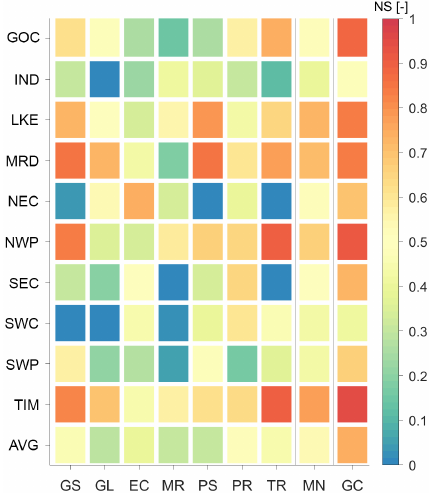
Figure 3. NS coefficients between the model and GRACE mas- con (cid:49) TWS over 10 Australian basins (in ordinate). The NS val- ues were computed based on CABLE (cid:49) TWS computed with seven different precipitation data (in abscissa), including GSWP3 (GS), GLDAS (GL), ECMWF (EC), MERRA (MR), PERSIANN (PR), TRMM (TR). The NS value of the mean (cid:49) TWS estimates (the av- erage of seven variants) is also shown (MN). The area-weighted av- erage NS value over all basins is also shown (AVG). The NS value of (cid:49) TWS from the GRACE-combined (GC) approach is shown in the last column. The full name of the basins can be found in Fig.